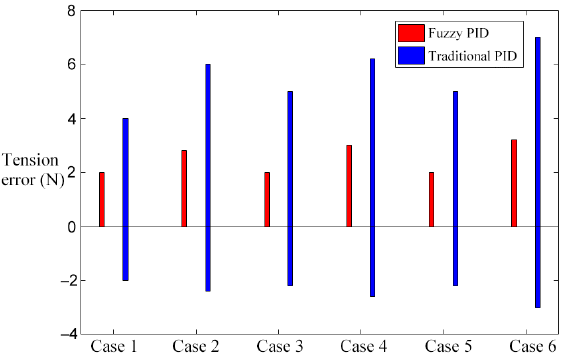
Figure 18. Six situations of tension fluctuation.